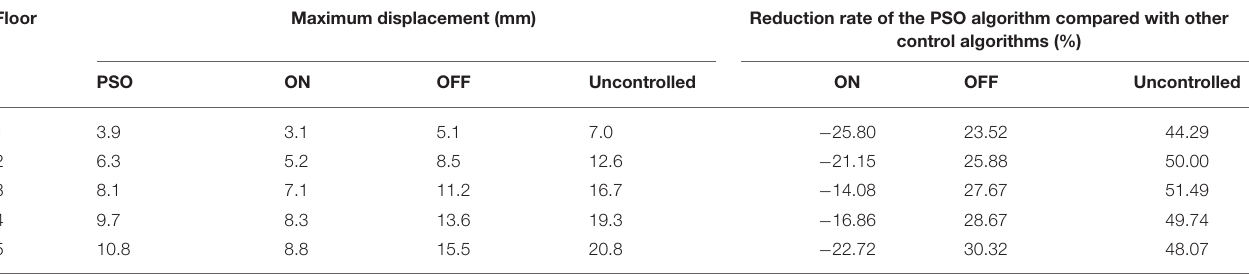
TABLE 3 | The maximum displacement responses comparison of each floor (Taft).